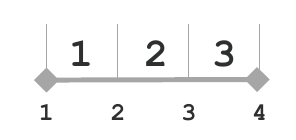
Figure 2. Fencepost error problem